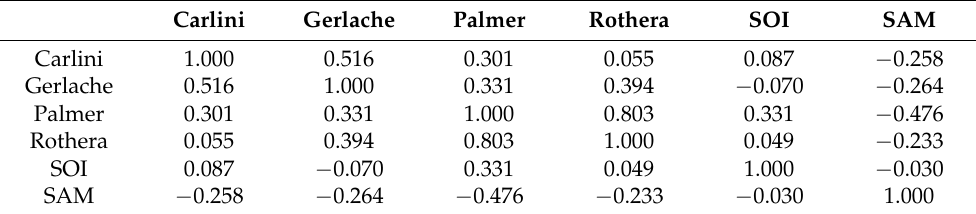
PCA (Table 6). Table 5. Correlation matrix used to develop the principal component analysis of Z SST , Z SOI , and Z SAM